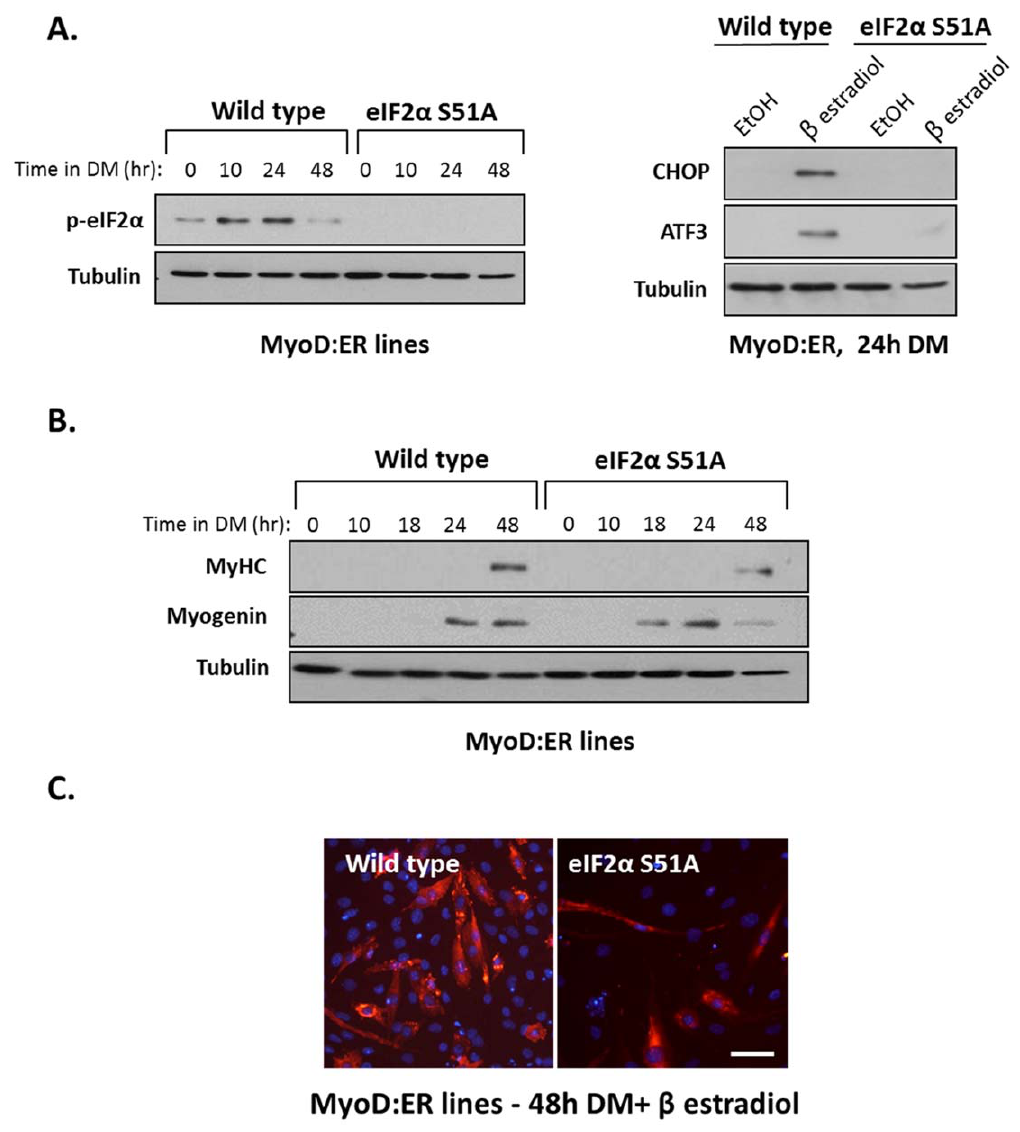
Figure 2. Muscle differentiation of eIF2 a S51A knockin cells. Wild type eIF2 a and mutated eIF2 a S51A fibroblasts were infected with viruses encoding MyoD:ER protein. (A) Cells were allowed to differentiate in DM and b estradiol (0.1 m M) for the indicated time periods and proteins were analyzed by Western blot (left panel). Cells were grown in DM and ethanol or b estradiol (0.1 m M) for 24 hours and CHOP and ATF3 proteins were analyzed by Western blot (right panel). (B) Cell lines were grown as is described in A, and were analyzed by Western blot. (C) Cell lines were grown in DM for 48 hours. Cells were immunostained with an anti MyHC antibody (MF20); MyHC in red, DAPI in blue. Bar, 50 m m.